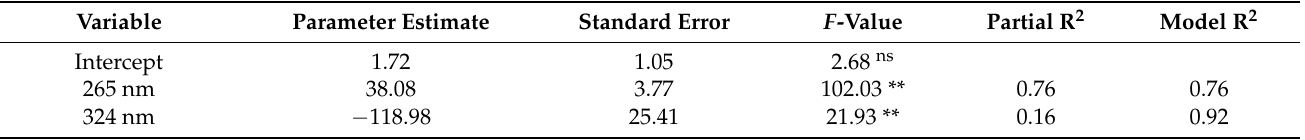
Table 5. Results of stepwise regression between zingiberene content as determined by GC-FID and absorbance values from 200 to 350 nm for the BC3F5 generation.